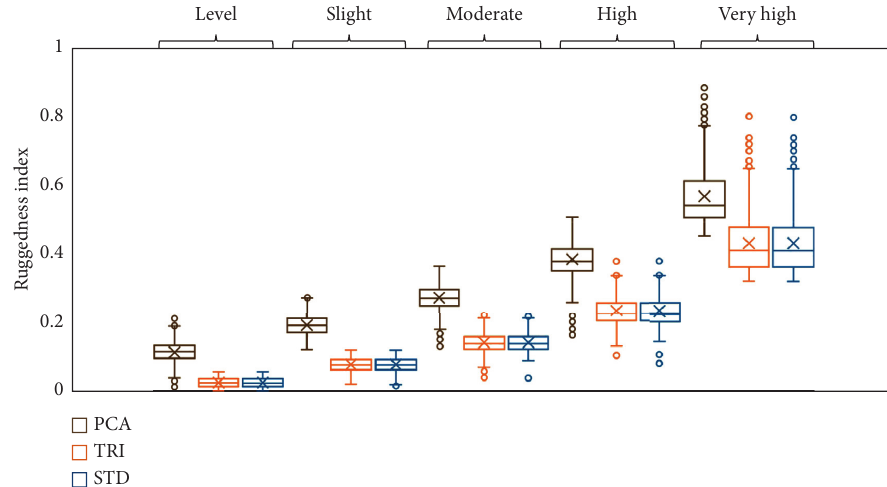
Figure 18: Box plot comparison between the investigated